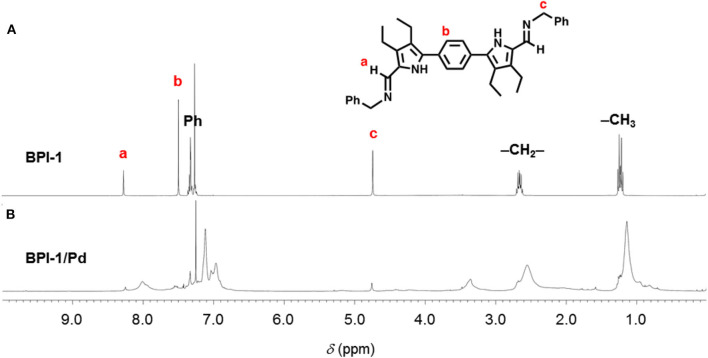
1H NMR spectra (400 MHz, CDCl3) of (A) BPI-1 and (B) a product formed upon mixing BPI-1 and Pd(OAc)2 at 1:1 ratio.